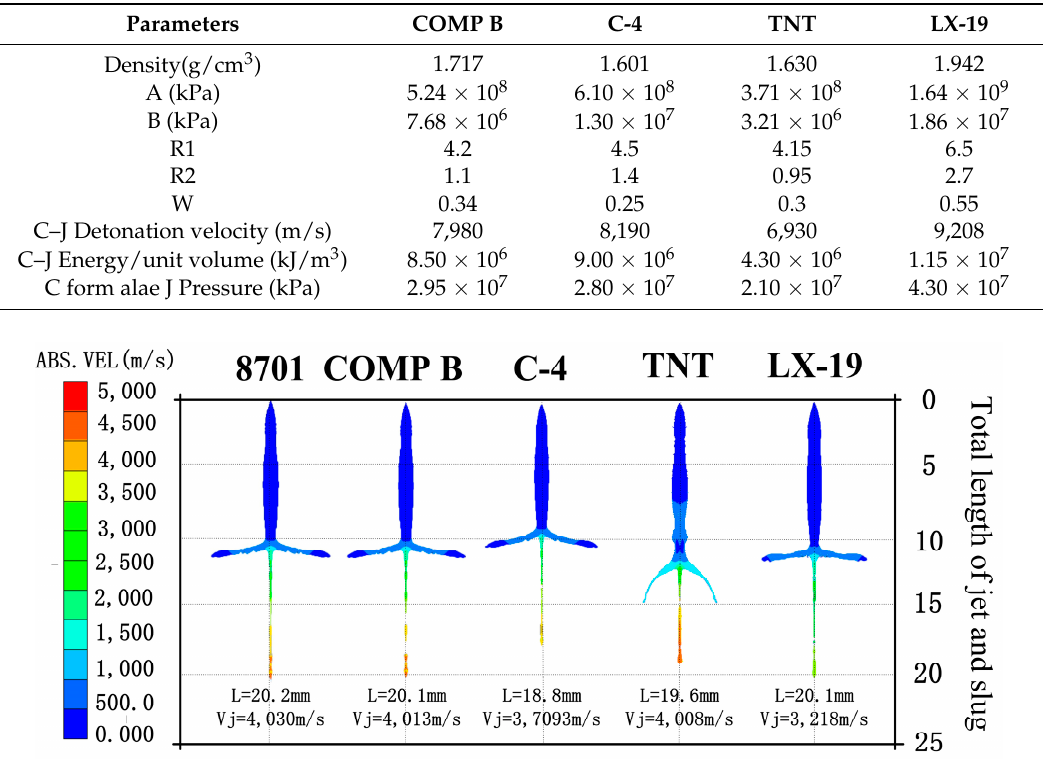
Figure 12. Velocity distribution of different explosives.